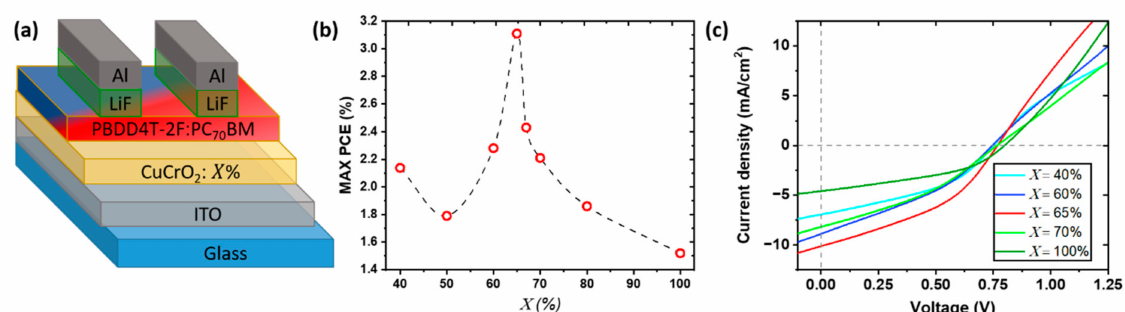
Figure 3. Scheme of the integration of out of stoichiometry CuCrO 2 thin film as HTL in OSCs based on the active layer of PBDD4T-2F:PC 70 BM 1.5:1. ( a ) Schematic structure of the assembled OSC with out of stoichiometry CuCrO 2 thin films as HTL, labelled with CuCrO 2 : X . ( b ) PCE variation as a function of X for the best device, and ( c ) corresponding J-V characteristic under A.M. 1.5 illumination. In the latter, not all compositions are presented for higher